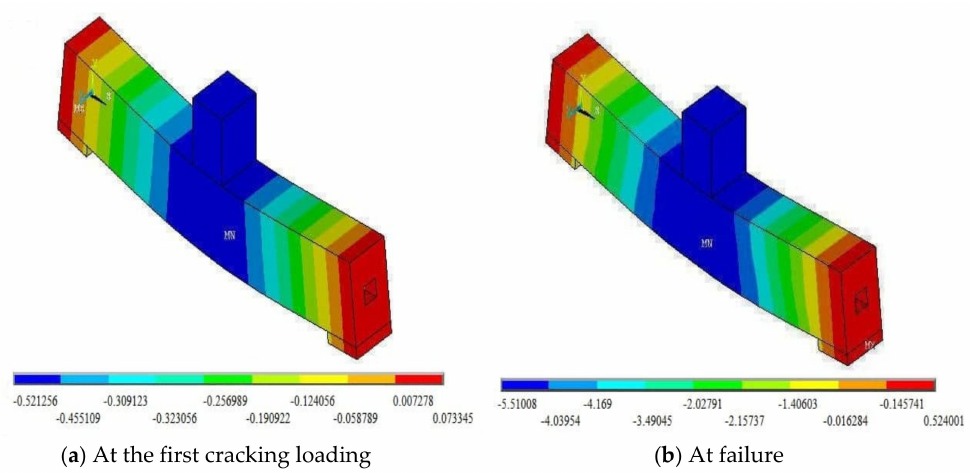
Figure 11. 3D deflection contours of beam model B3 at different loading